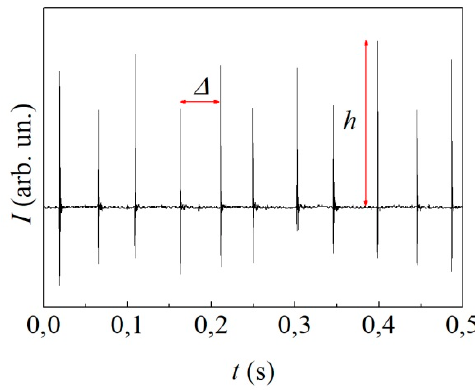
Figure 4. A sequence of signals generated by the piezoelectric sensor. The period between consecutive signals, ∆ , and the height of signals, ℎ , utilized as a measure of intensity are indicated.